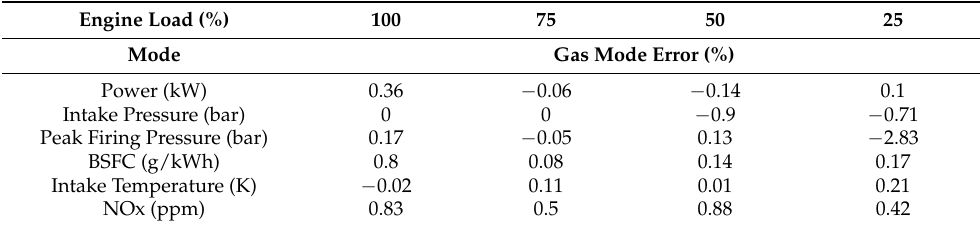
Table 5. Calculation error of the gas mode.